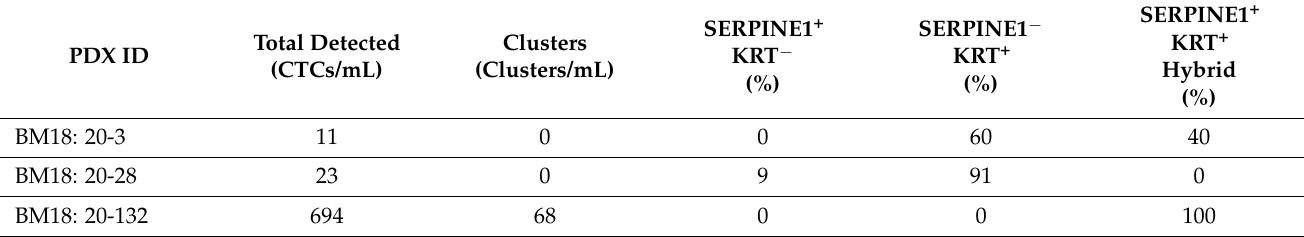
Figure 7. Immunofluorescent staining for SERPINE1 (red) and KRT 8/18/19 (green) in PDX-derived CTCs. Representative images using LuCaP96 mouse blood of single CTCs staining positive for ( a ) SERPINE1 only, ( b ) KRT only or ( c ) both SERPINE1 and KRT. ( d ) Representative images using LuCaP70 mouse blood of SERPINE1 + KRT + CTC cluster surrounded by murine PBMCs. Scale bar denotes 5 µm. Table 4. Summary of circulating tumour cell SERPINE1/KRT immunofluorescence cytology for all PDX blood samples.